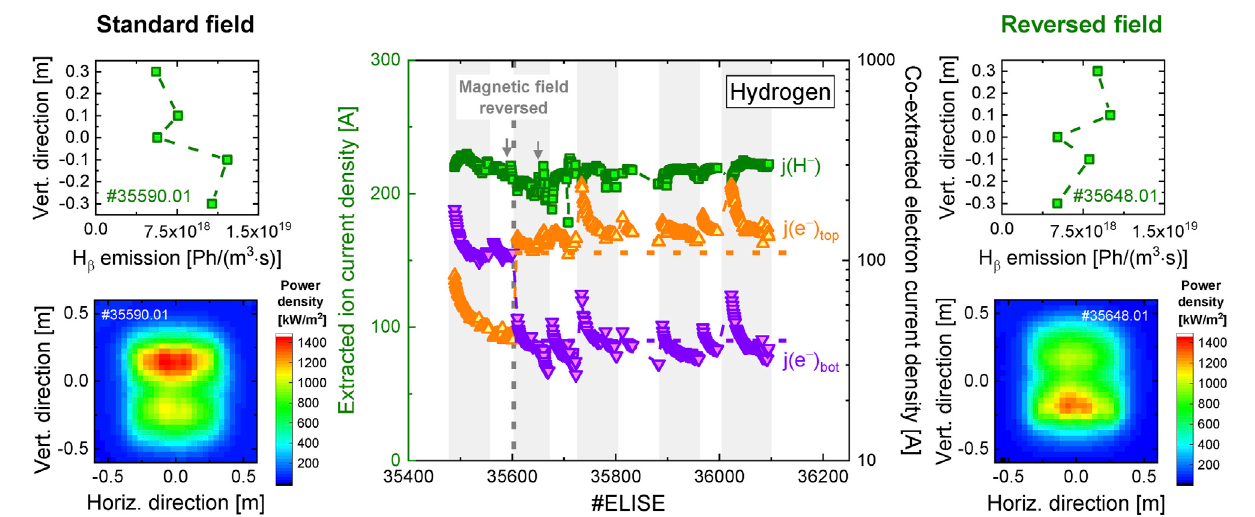
FIGURE 7 | Center: extracted negative ion current density and co-extracted electron current density for the top and bottom segment of the extraction system measured before and after reversing the magnetic fi lter fi eld at ELISE (based on [41]). Left and right: vertical pro fi les of the Balmer- β emission close to the PG, and beam footprints at the calorimeter recorded with an IR camera for both polarities of the magnetic fi lter.